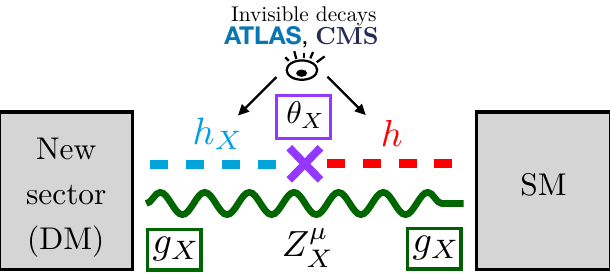
Figure 1 . Collider experiments can search for dark matter through the SM Higgs boson decays to invisible. However, in theories where the dynamical origin of the dark matter mass can be understood, those decays can be strongly suppressed by the scalar mixing angle. Consequently, it might be more convenient to look for signals arising from the invisible decays of a the new Higgs, h X , responsible for the dark matter mass and the breaking of the new symmetry U(1) X